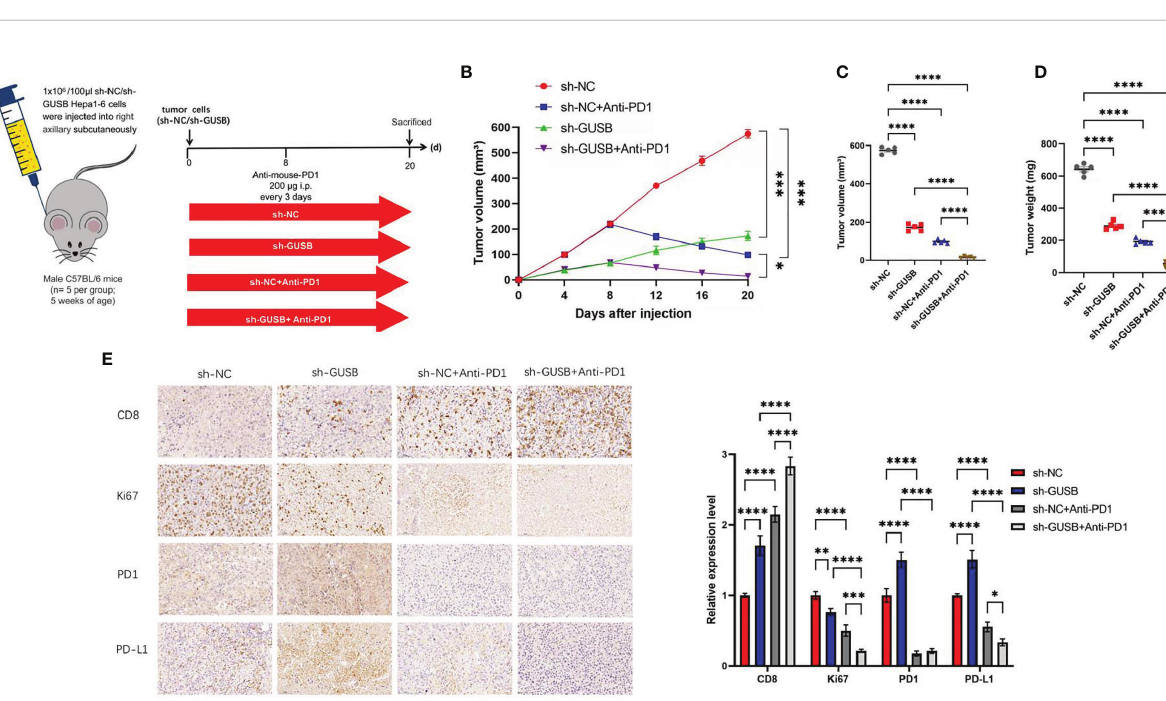
FIGURE 5 | Knockdown of GUSB enhanced the anti-HCC effect when combined with anti-PD1 therapy in vivo . (A) Schematic diagram of animal experiment. We injected Hepa1-6 cells (sh-NC, sh-GUSB, sh-NC + anti-PD1, and sh-GUSB + anti-PD1) into C57BL/6 mice. (B – D) The volume (B, C) and weight (D) statistics of subcutaneous tumors in the respective groups (sh-NC, sh-GUSB, sh-NC + anti-PD1, sh-GUSB + anti-PD1). (E) Immunohistochemistry result of CD8, Ki67, PD1, and PD-L1 expression in the respective groups. Scar bar, 50 um. * P < 0.05; ** P < 0.01; *** P < 0.001; **** P <